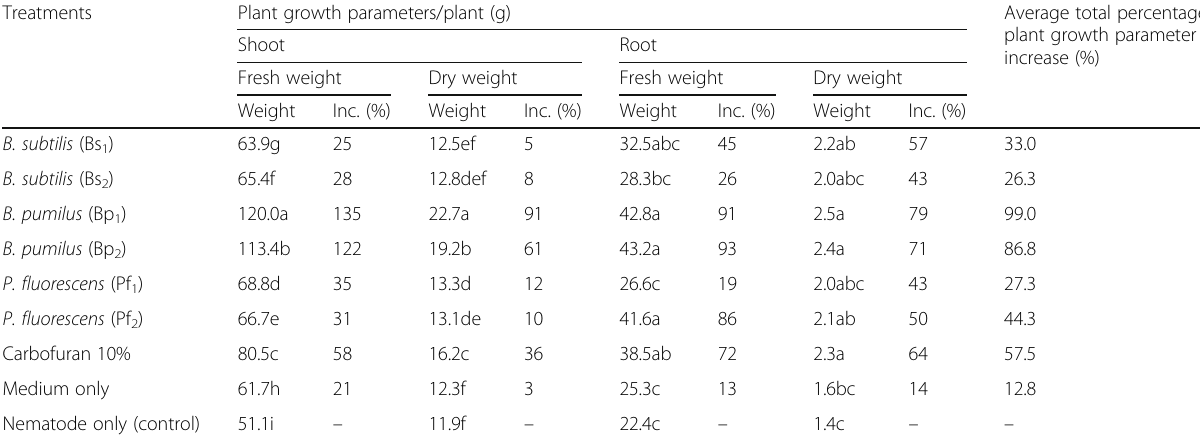
Table 2 Effects of Bacillus subtilis , B. pumilus , and Pseudomonas fluorescens isolates on vegetative growth parameters of cowpea grown under screen house conditions and infected with root knot nematode, Meloidogyne incognita Treatments